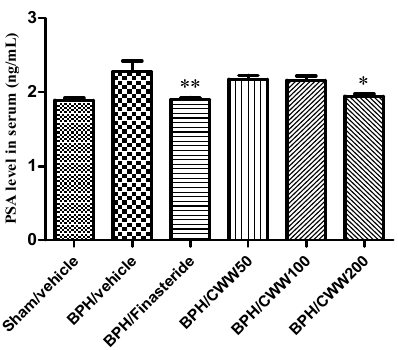
Figure 3. Effects of aqueous Cynanchum wilfordii extract (CWW) on serum prostate-specific antigen (PSA) levels. ** p < 0.01 and * p < 0.05 vs. BPH/vehicle group. BPH: benign prostatic hyperplasia; Sham/vehicle: sham-operated and phosphate-buffered saline (PBS), oral (p.o.); BPH/vehicle: testosterone, subcutaneous (s.c.) and PBS, p.o.; BPH/finasteride: testosterone, s.c. and finasteride 5 mg/kg, p.o.; BPH/CWW 50: testosterone, s.c. and CWW 50 mg/kg, p.o.; BPH/CWW 100: testosterone, s.c. and CWW 100 mg/kg, p.o.; BPH/CWW 200: testosterone, s.c. and CWW 200 mg/kg, p.o.